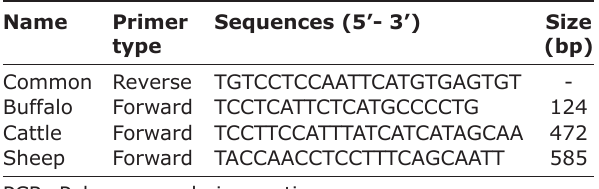
Table-3: Primers used in multiplex PCR. Name